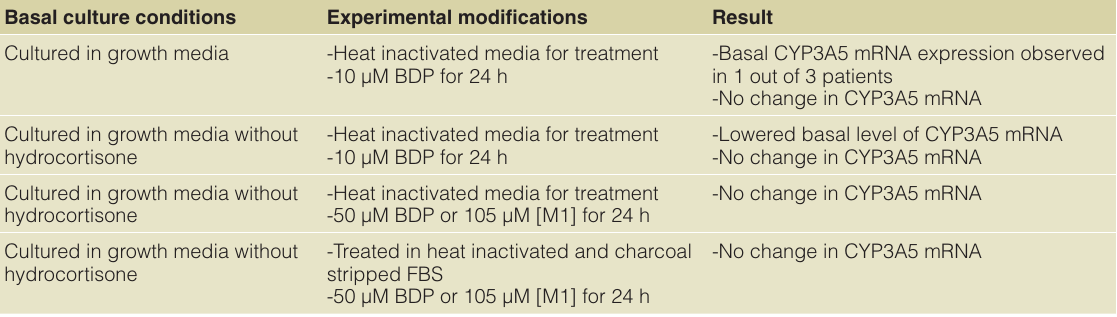
Table 3. Modifications made to SAEC culture media. Basal culture